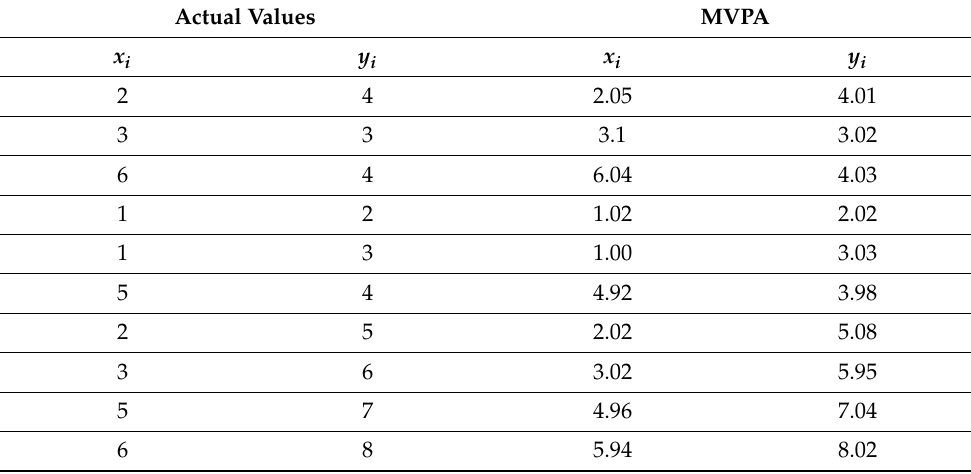
Table 6. Comparison of actual locations with those obtained using MVPA for outdoor application.